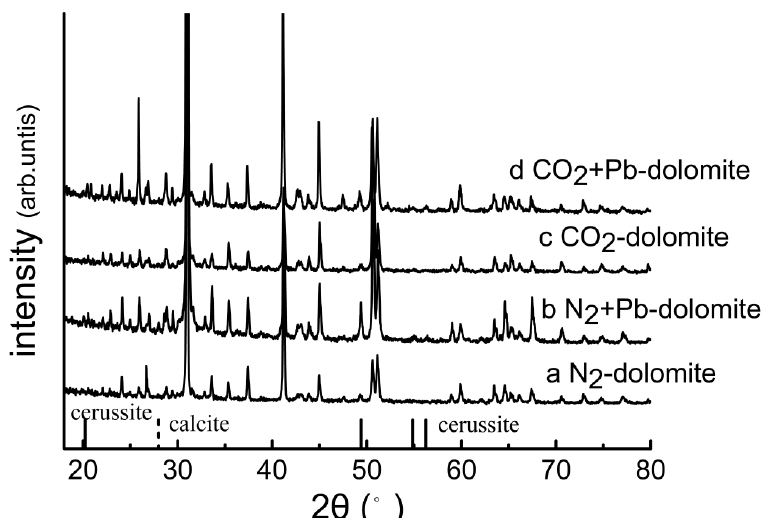
Figure 4. X-ray diffraction patterns of dolomite powder under different environmental conditions: (a) charged with N 2 ; (b) charged with N 2 and exposed to Pb; (c) charged with CO 2 ; (d) charged with CO 2 and exposed to Pb; the solid vertical line is the standard dolomite (PbCO 3 ) peak position; the dashed vertical line is the standard calcite (CaCO 3 ) peak position.